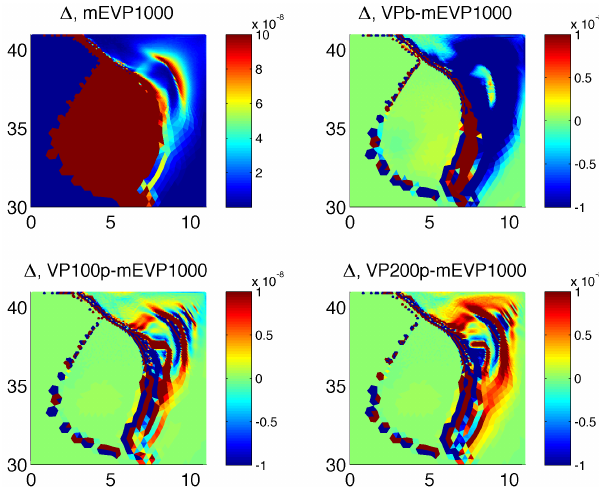
Figure 7. (cid:49) (s − 1 ) after 1 month of simulations in case C in mEVP1000 (top left) and differences between the solutions: VPb-mEVP500 (top right), VP100p-mEVP1000 (bottom left) and VP200p-mEVP1000 (bottom right). Additional Picard iterations in the VP method substantially modify the differences, reducing them in the northeast corner. The convergence is not reached even for 200 Picard